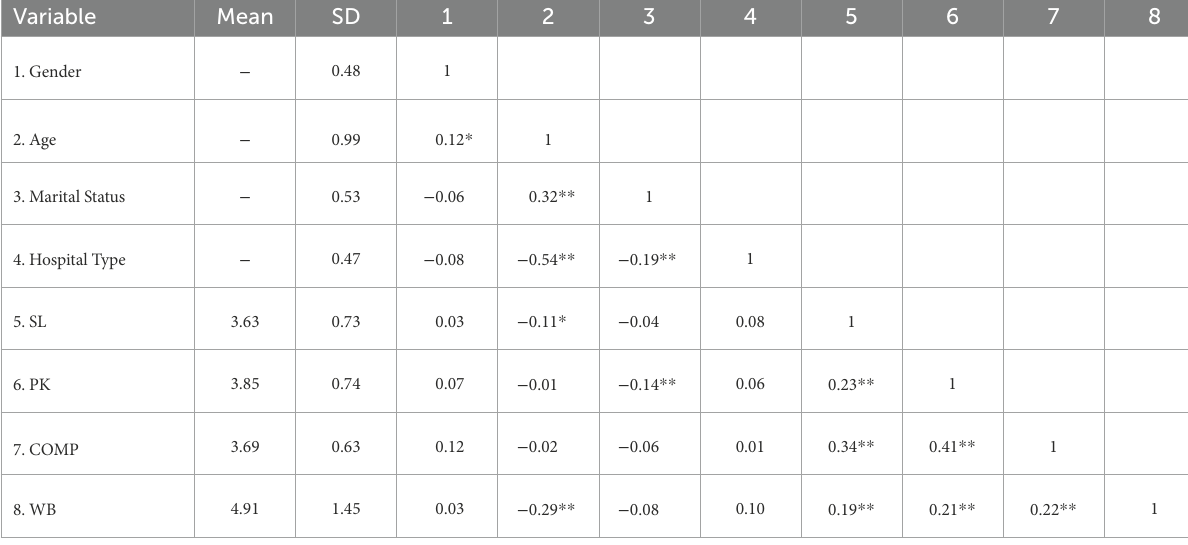
N = 366. SL, sustainable leadership; PK, procedural knowledge; COMP, compassion; WB, wellbeing. ** Correlation is significant at the 0.01 level (2-tailed). *Correlation is significant at the 0.05 level (2-tailed).